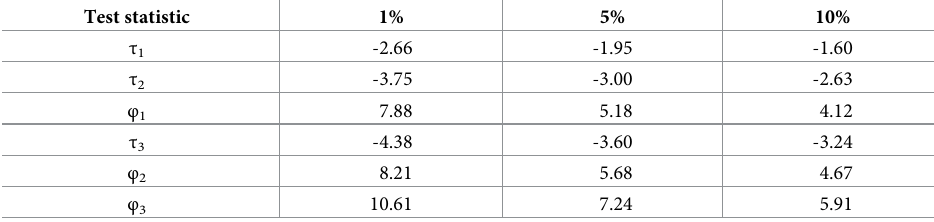
Table 2. Critical values for each Dickey-Fuller test statistic.